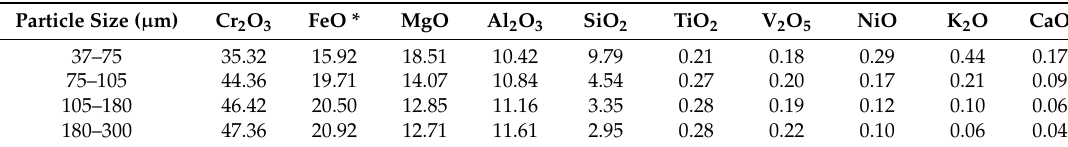
Table 1. Chemical composition of the chromite of four size fractions.